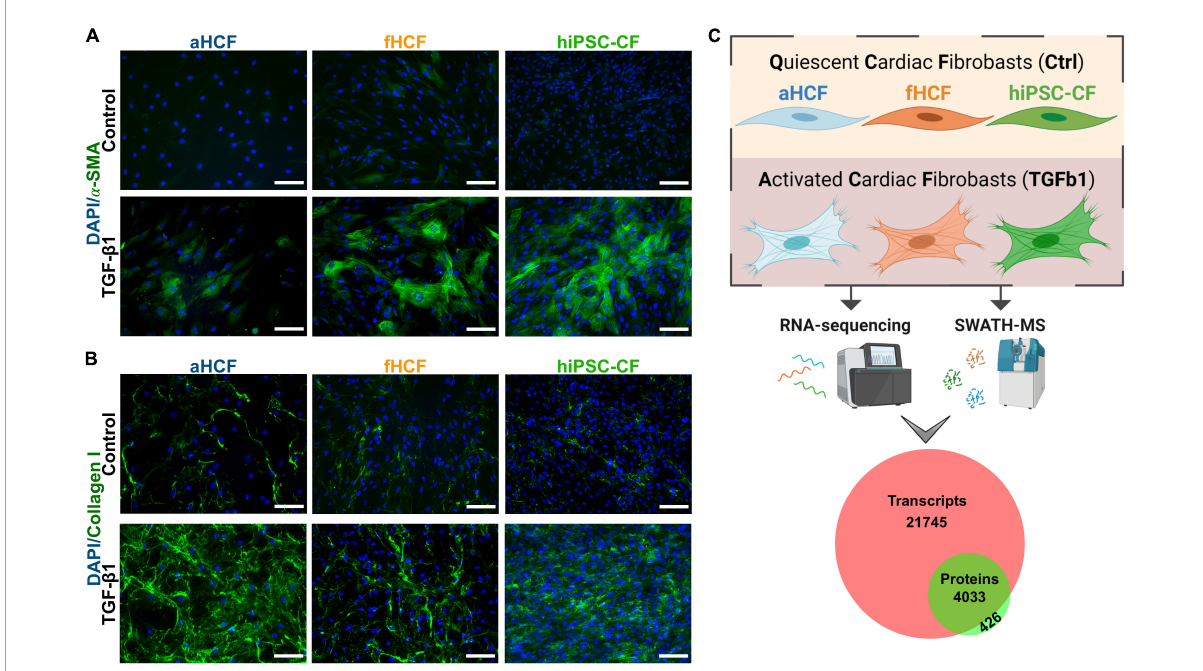
FIGURE1 Transcriptomic and proteomic analysis of activated and quiescent CF (A) TGF- β 1 treated CF show hallmarks of CF activation: Formation of smooth muscle actin ( α -SMA) stress fibers and (B) increased collagen I deposition. Scale: 100 µ m. (C) Overview of study design: three sources of CF were used for a comparative analysis of the transcriptome (through high-throughput RNA-sequencing) and the proteome (through SWATH-MS) of a quiescent state (non-activated) and an activated state. Three independent experiments were performed for each CF source. The analysis resulted in a dataset of 25,779 transcripts and 4,659 proteins. Venn diagram shows coverage and overlap between total identified transcripts and